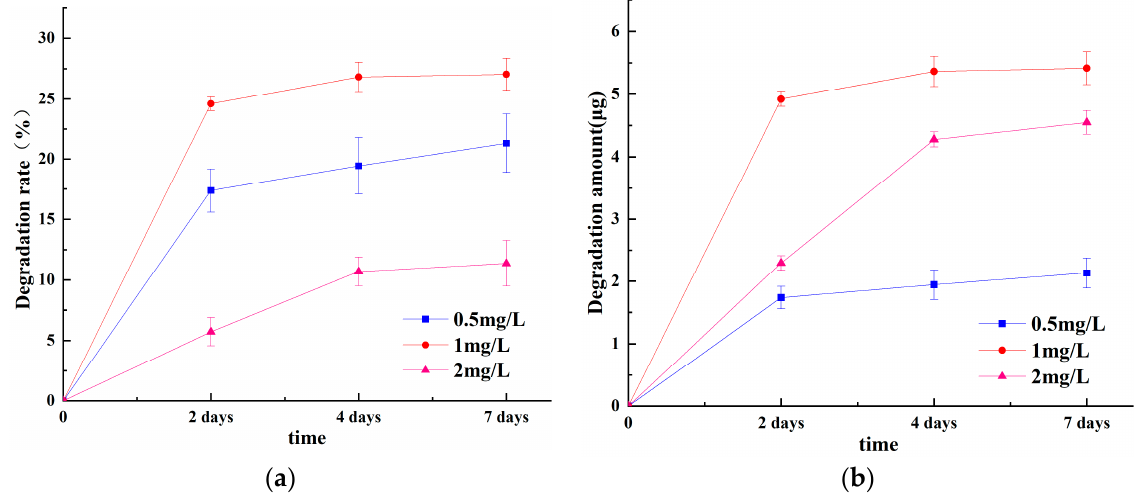
Figure 2. ( a ) Abamectin degradation rate at different times and abamectin concentrations. Description of what is contained in the first panel; ( b ) The level of abamectin degradation at different times and abamectin concentrations. Error bars represent the standard deviation of three replicate experiments.